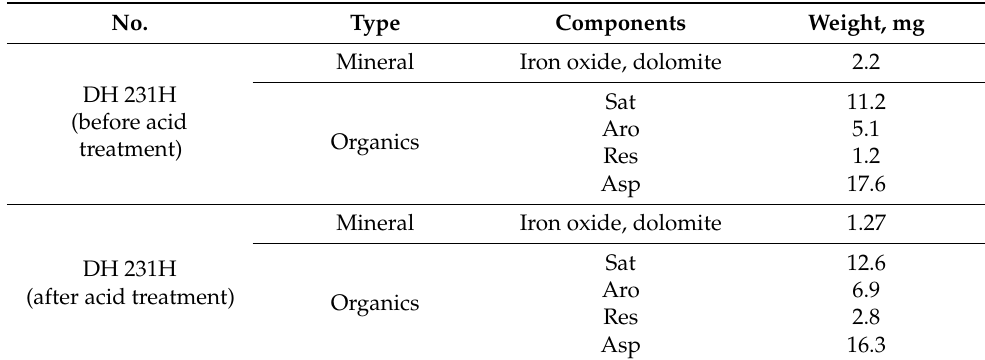
Figure 4. Micrograph of the inorganic and organic portions of the wellhead blockage (( a ): reflected light images; ( b , c ): polarized light images). Table 2. Absolute mass statistics of components before and after acidification of wellhead blockage in Well